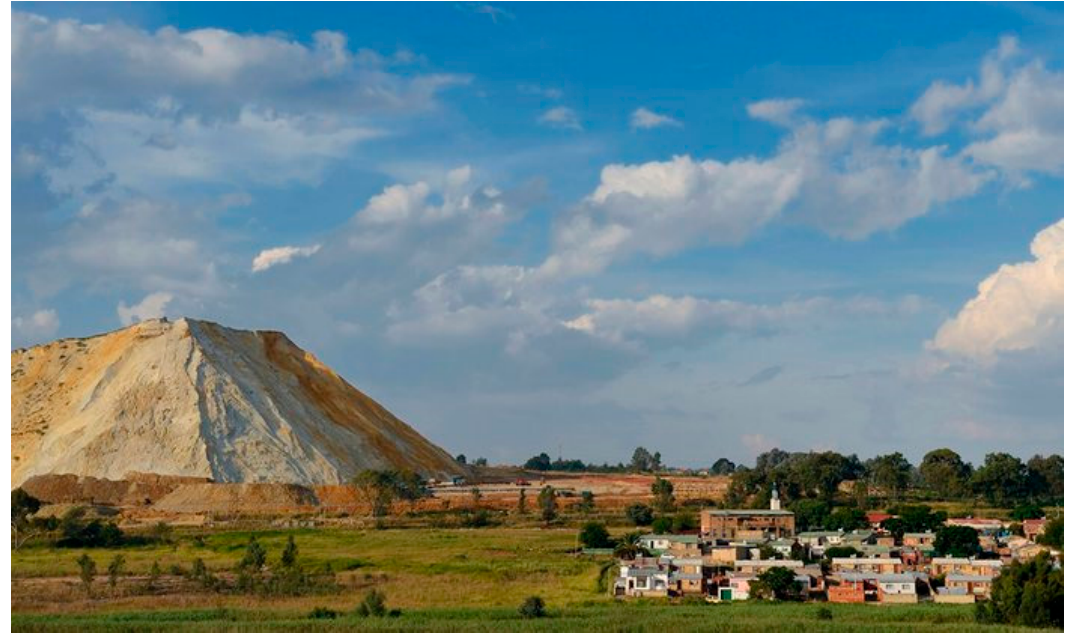
Figure 1. Johannesburg’s Soweto Riverlea neighborhood in the shadow of a gold mine slag heap. Photograph: Alamy, 2015. Source: http://www.theguardian.com/cities/2015/jul/06/radioactive-city-